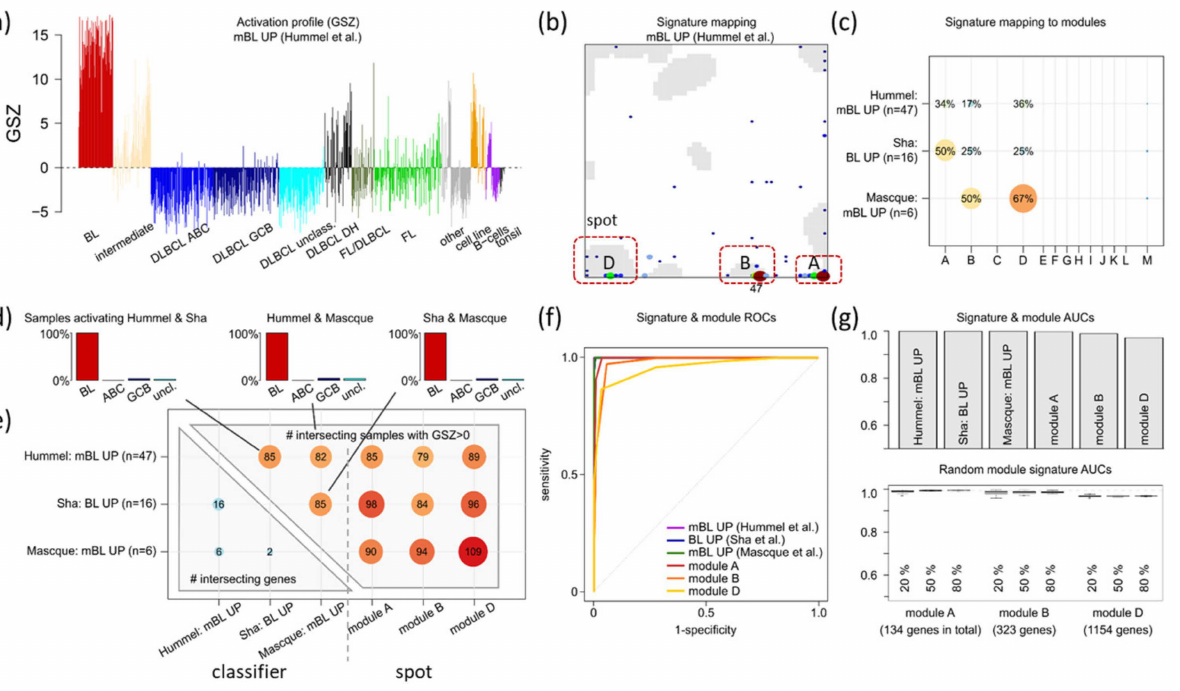
Figure 6. Identifying BL: ( a ) Gene set Z-score (GSZ) profile of the BL_up signature of Hummel et al. [3] along different sample strata of the MMML-data set showed activation in BL and deactivation in DLBCL (see Figure A8 for the other signatures). ( b ) Mapping of BL_up classifier genes of Hum- mel et al. [3] into the transcriptome landscape of lymphomas reveals their accumulation in/near spots A, B and D. Genes are shown by dots (larger dots indicate multiple occupied pixels) while spots are marked in grey. ( c ) Distribution of BL_up signature genes (rows) among spot modules (columns) indicates their unique presence in spot B and biased accumulation of Sha et al. signature genes in spot D related to proliferative cell functions. ( d ) Overlap fraction of samples of different strata found activated (GSZ >0) in pairs of BL_up classifiers which reflects 100% identification of BL and only weak (<5%) detection of “false-positive” non-BL lymphomas. ( e ) Mutual overlap matrix indicates overlapping BL_up signature genes (left lower triangle) and overlapped detection of samples with GSZ > 0 for the respective signatures and modules (right part). The signature of Masque et al. [18] and spot D detect most BL cases, however, also a relatively large number of DLBCL with proliferative characteristics (see Figures A7 and A10). ( f ) ROCs of the BL_up signatures reveal only a tiny penalty for spots A and B compared with the signatures taken from literature (see Figure A10). ( g ) Area under ROC (AUC) of the curves shown in part f. AUC is virtually independent of the number of genes randomly selected from the spot modules (part below, fraction of selected genes is 20–80%, 100 ×